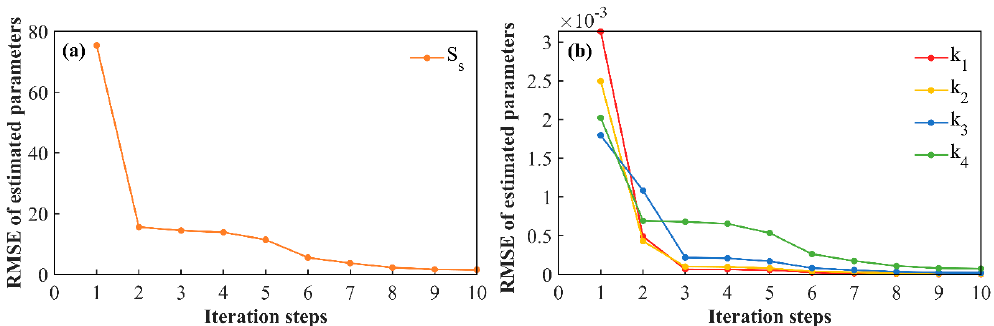
Figure 10. The RMSE of model parameters estimated in Case 2. ( a ) represents the RMSE of source strength at different iteration steps. ( b ) represents the RMSE of rate constants of the reactive transport model at different iteration steps. Different coloured lines denote the RMSE of each parameter at different iteration steps.